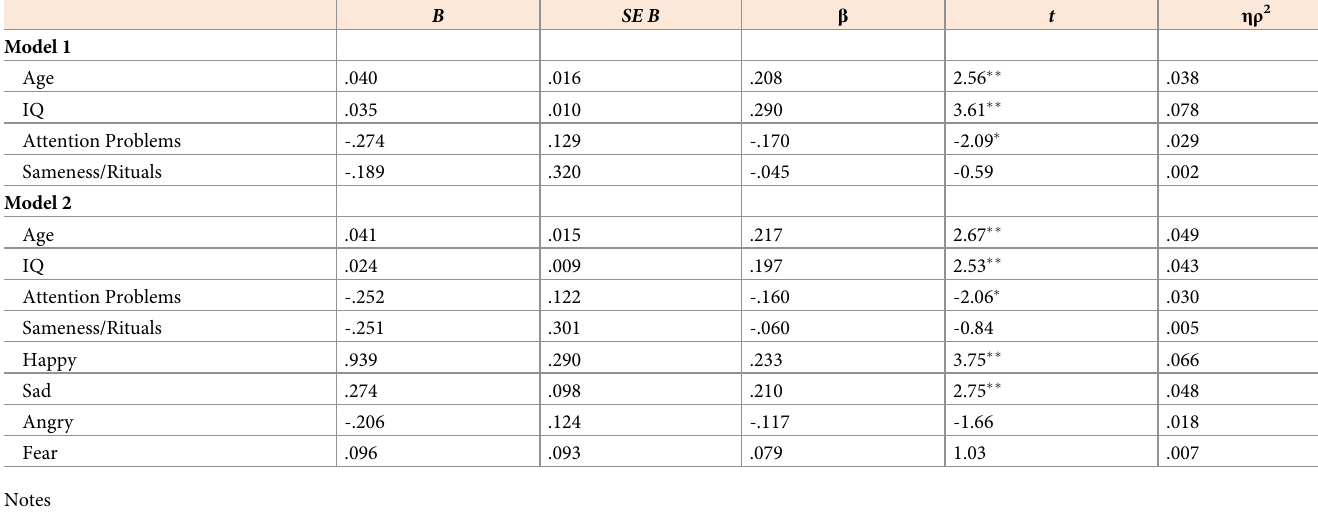
Table 6. Results of regression analysis predicting total social perception